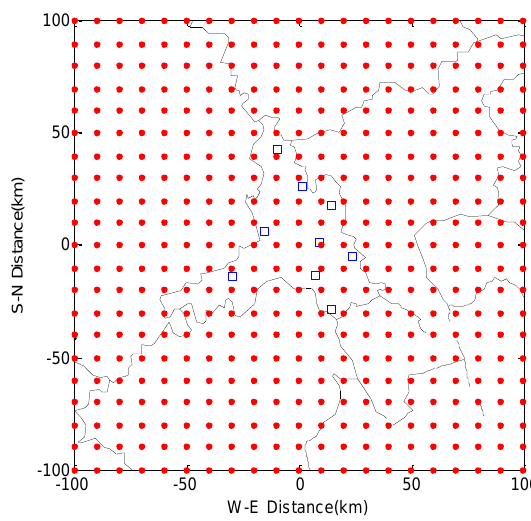
Figure 8. The simulation model of estimating location error.